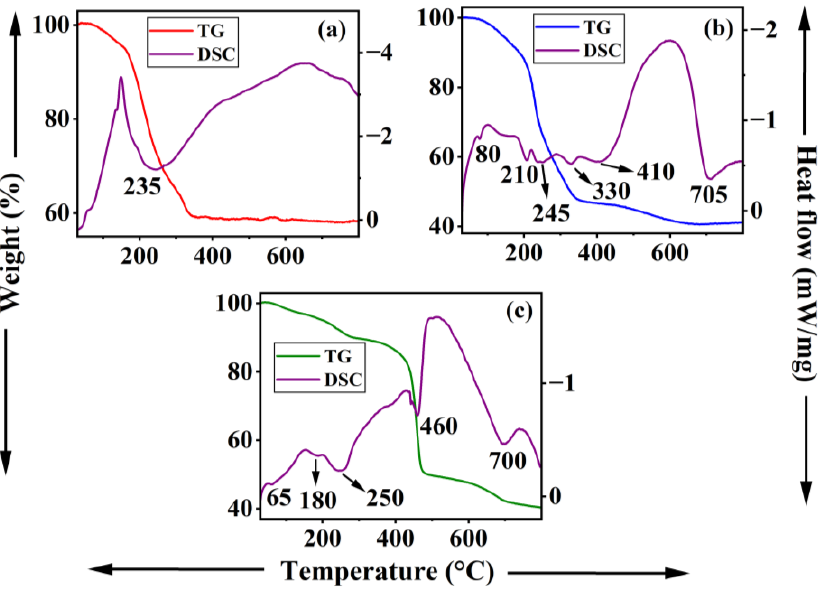
Figure 3. TG-DSC traces of ( a ) pristine LDH ([LiAl 2 (OH) 6 ]OH · 2H 2 O), ( b ) Li-Al-DS LDH, and ( c ) Li-Al-DBS LDH.